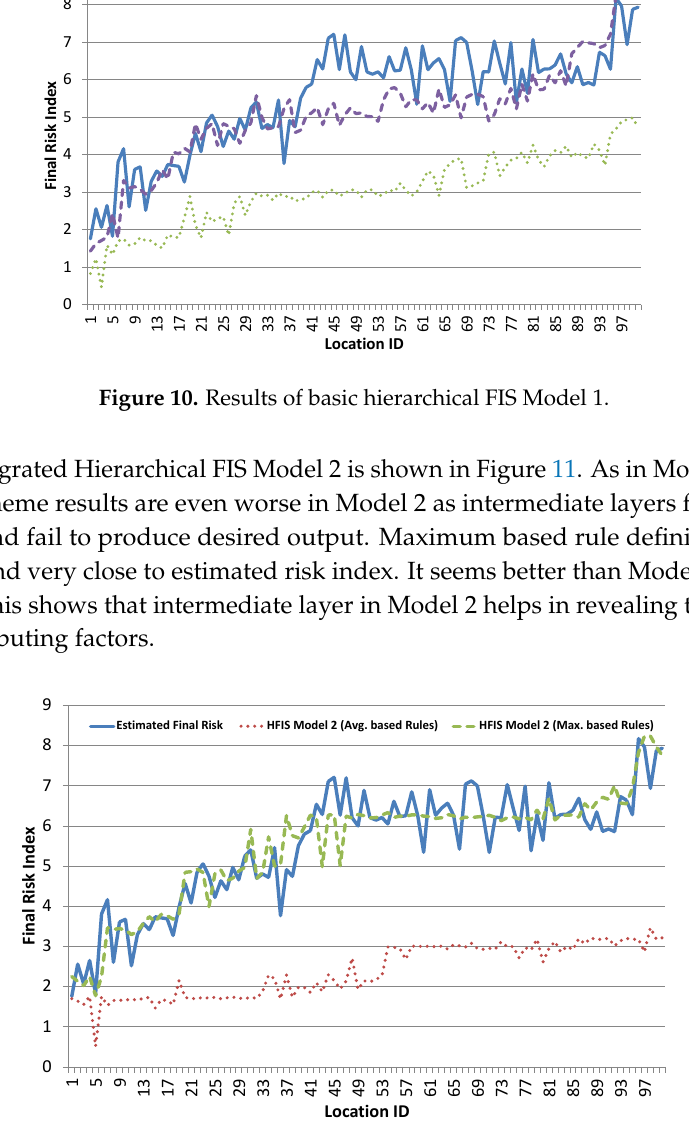
Figure 11. Results of integrated hierarchical FIS Model